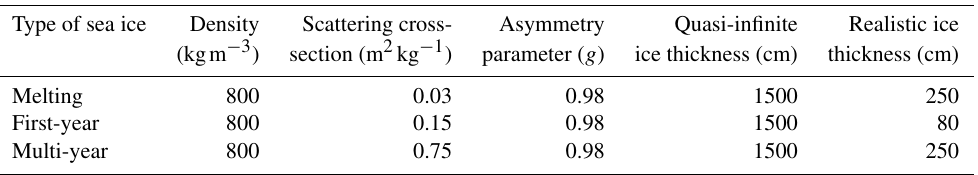
Table 1. TUV-snow model sea ice input parameters derived from the literature (Grenfell and Maykut, 1977; Perovich, 1990, 1996; Timco and Frederking, 1996; Gerland et al., 1999) and previously used in other studies (e.g. King et al., 2005; France, 2008; France et al., 2011; Marks and King, 2013, 2014; Lamare et al.,